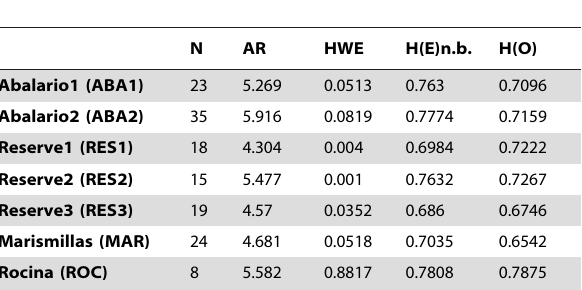
Table 1. Genetic diversity and Hardy-Weinberg equilibrium tests in the seven populations throughout Don˜ana Natural